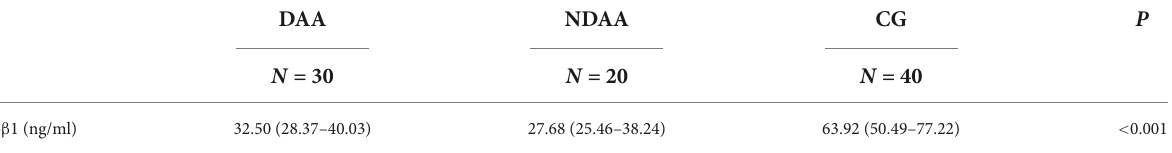
TABLE 2 TGF- β 1 concentrations in groups according to aortic size and in reference group.